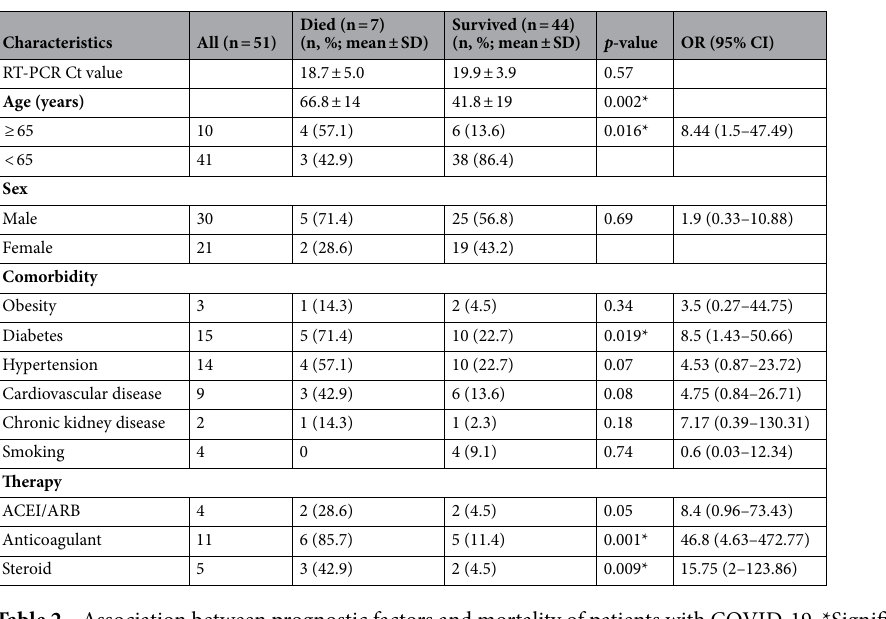
Table 2. Association between prognostic factors and mortality of patients with COVID-19. *Significant ( p < 0.05). ACEI angiotensin-converting enzyme inhibitors, ARB angiotensin receptor blocker, CI confidence interval, OR odds